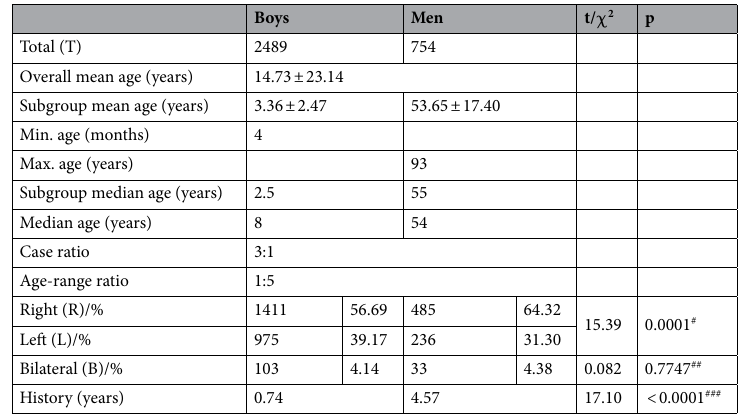
Table 1. Clinical details included in the study. # χ 2 test, ##( R + L) vs. B, χ 2 test, ### unpaired t test.